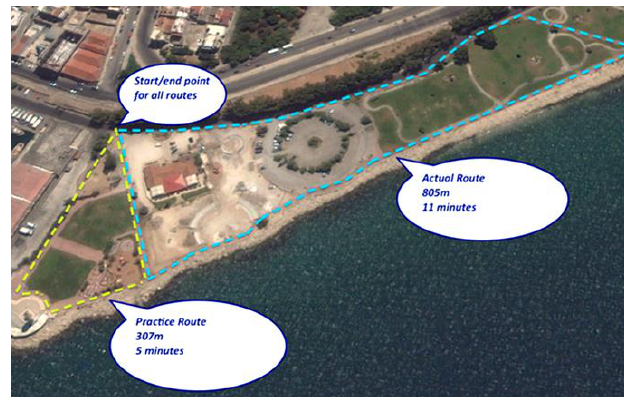
Figure 3: Study routes in [ blinded ] with distances and approximate times